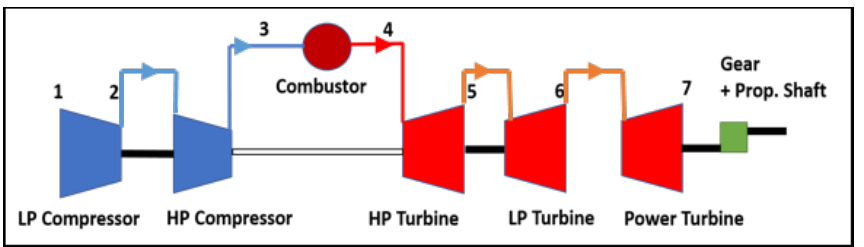
Figure 2. Gas turbine scheme.